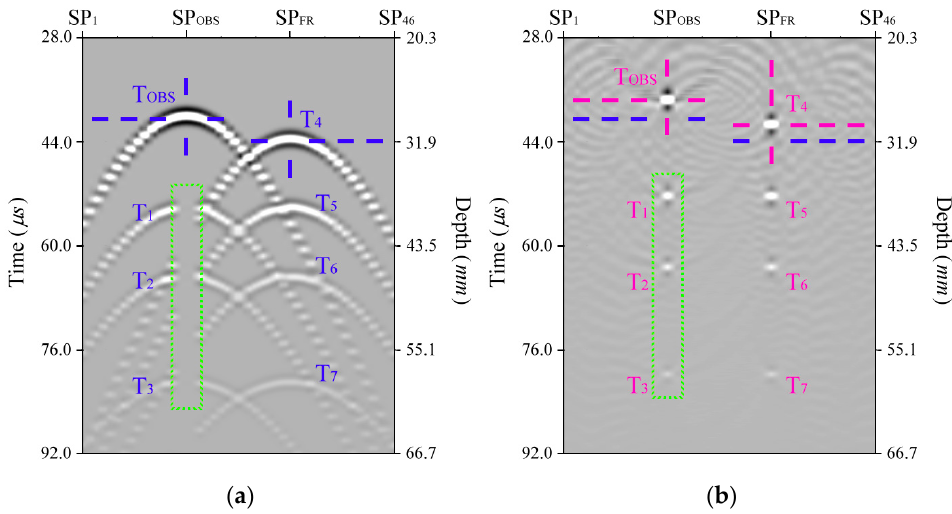
Figure 3. ( a ) A synthetic profile of the created model for a pitch/catch scan in the status of shadowed and shadow–free. Based on the theoretical echo paths, echoes that come from eight targets are individually shown as eight hyperbolic trajectories. The dotted rectangular line indicates an anechoic zone. ( b ) The output of the SAFT restoration from ( a ). The intersections of the dark-blue and pink cross shown in the figure stand for the theoretical imaged and restored positions of T OBS .